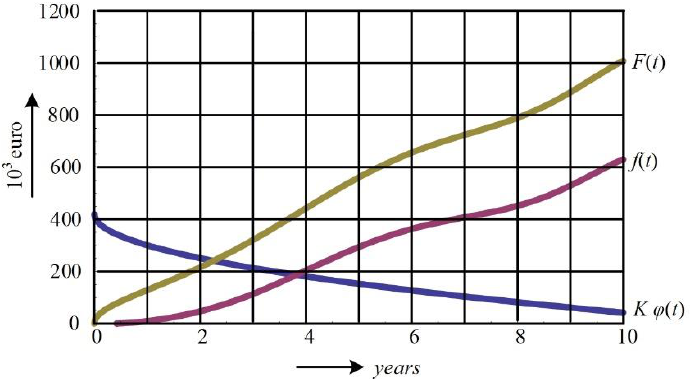
Figure 7. The function of cumulative maintenance costs f ( t ) and function of total costs of operating machine type 2.